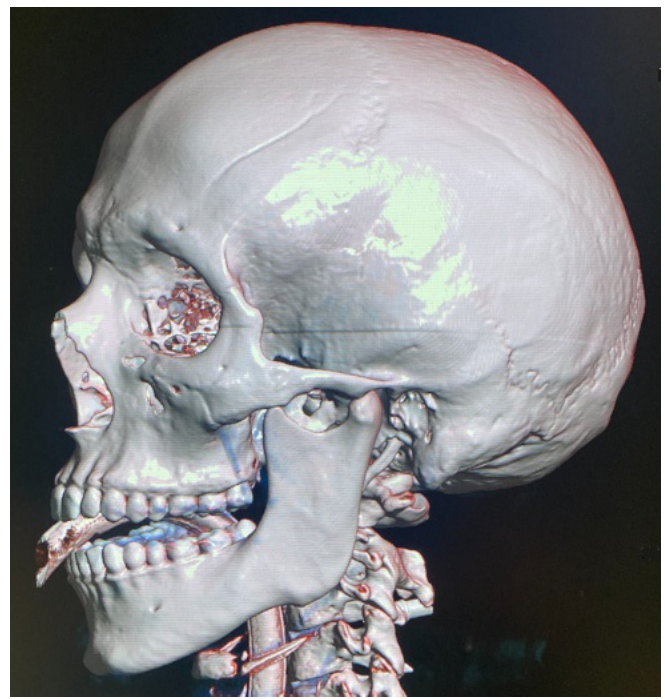
Figure 6. A classic orotracheal intubation visualized on an LDCT imaging. No proper bite and jaw position can be established in this intubation, and the technique of Altemir et al. is then sufficient modification to improve the oral cavity easy access.